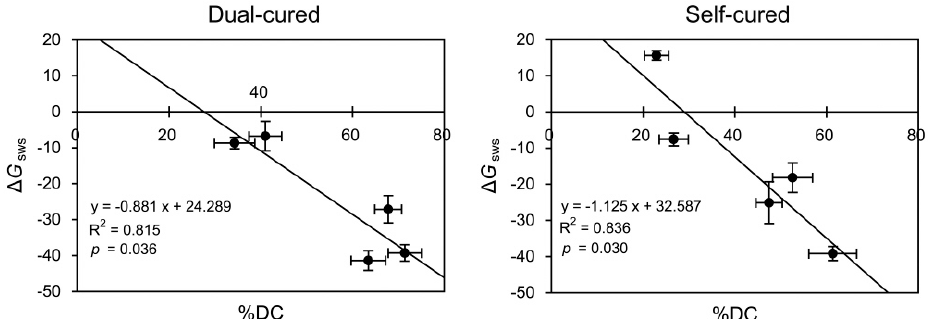
Figure 3. Graphs of linear regression of degree of hydrophilicity ( Δ G sws ) as a function of degree of conversion (%DC). The horizontal and vertical bars indicate standard deviations.